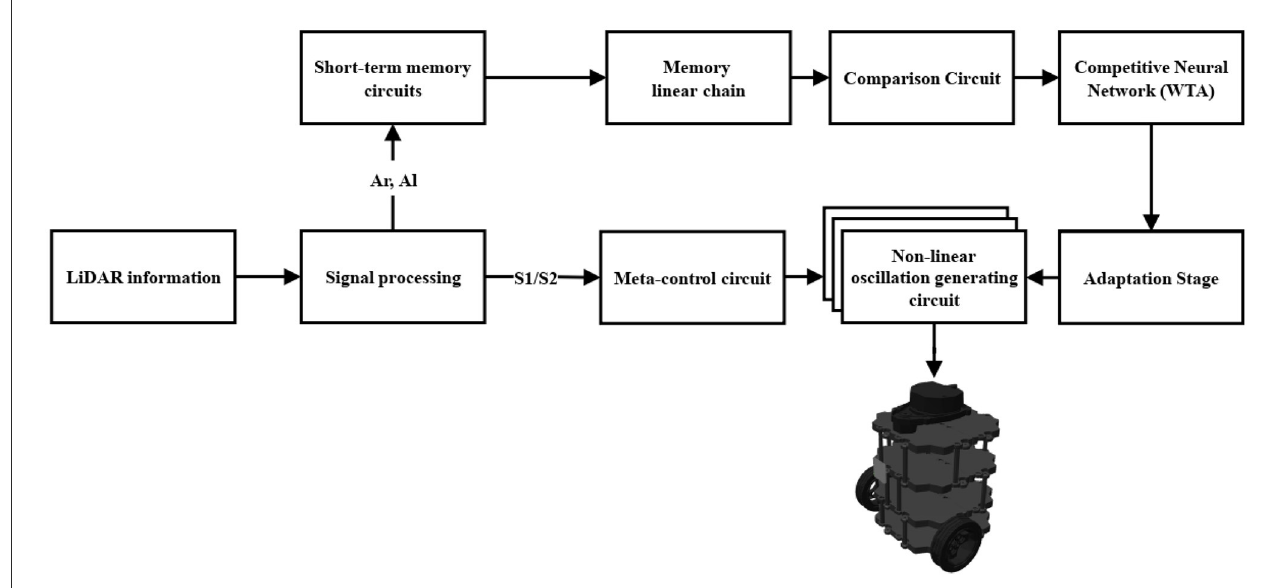
FIGURE1 Architecture of the bio-inspired network for the exploration